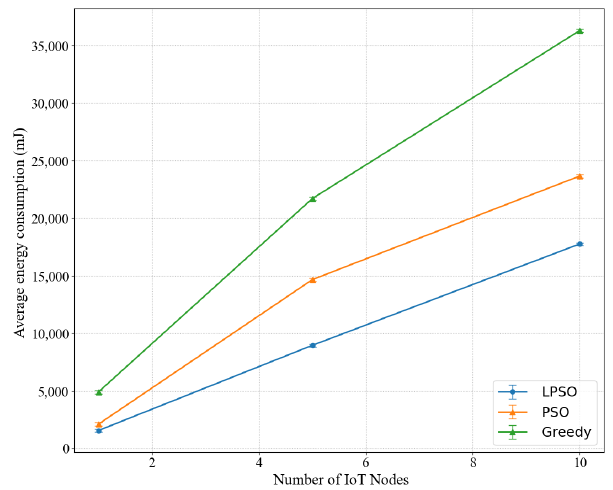
Figure 2. Influence of IoT equipment quantity on energy consumption.